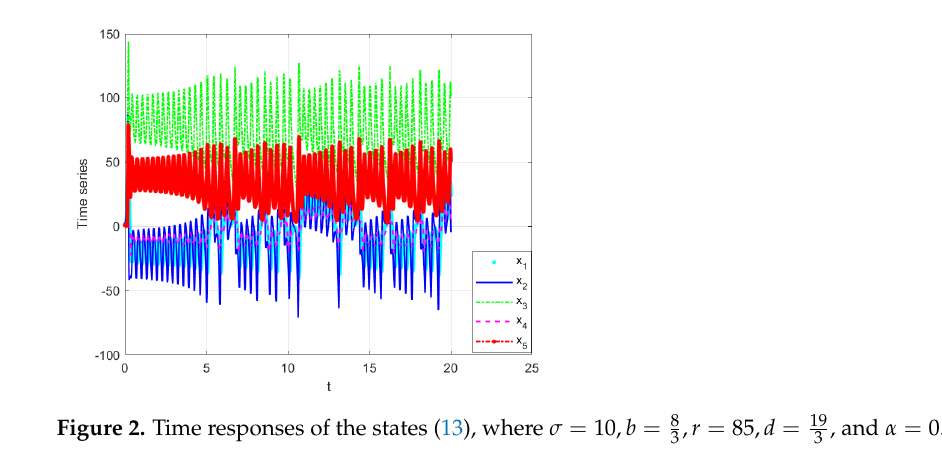
Figure 2. Time responses of the states (13), where σ = 10, b = 8